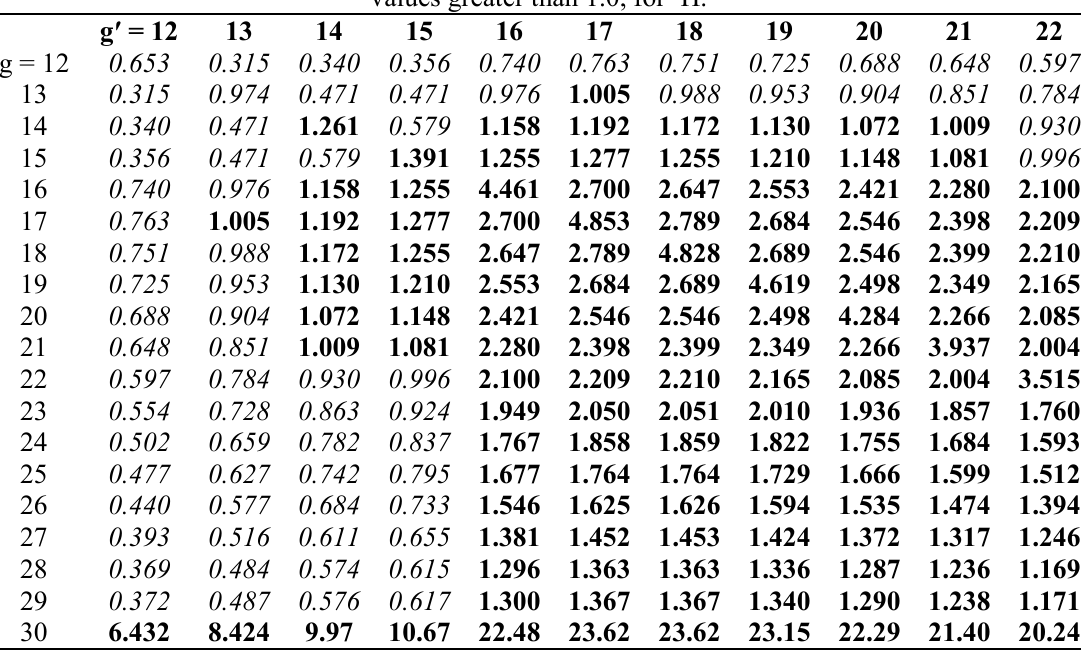
Table 2. Selected 2 nd -order relative sensitivities